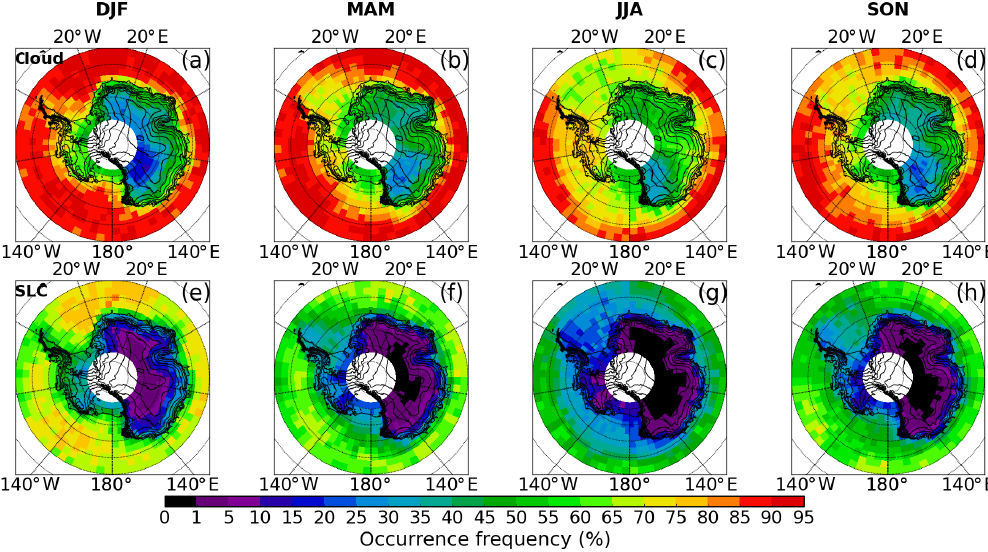
Figure 5. Geographical distribution of the total cloud fraction (a–d) and the total SLC fraction (e–h) for each of the four seasons based on 2007–2010